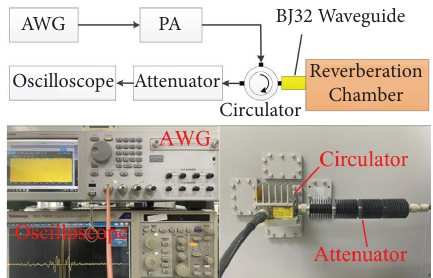
Figure 8: Photographs of the established USP acquisition